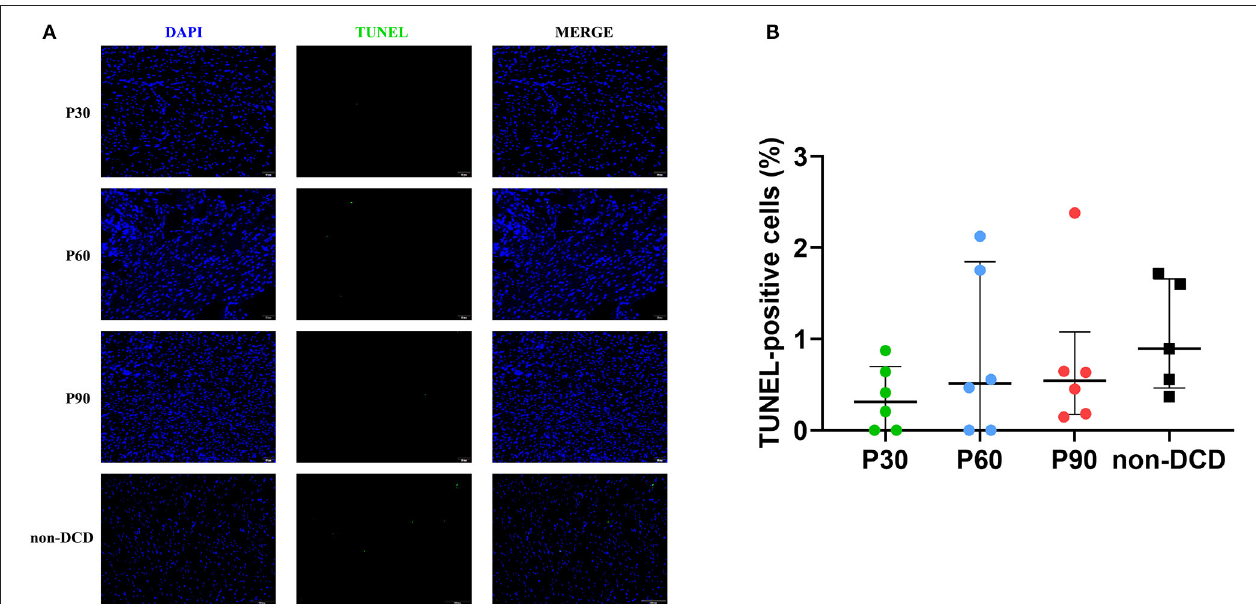
FIGURE 7 | Apoptosis evaluation of the donor heart during ESHP. (A) Representative photomicrographs of myocardial tissue stained with DAPI (blue), nuclei with fragmented DNA shown by TUNEL staining, and merged image (magnification of 20; scale length: 50 µ m); (B) Quantification of TUNEL-positive cells (as a percentage). n = 6 for P30, P60, and P90 groups, n = 5 for non-DCD group. Data represented as median and interquartile range. DAPI: 4 ′ ,6-diamino-2-phenylindole (DAPI, blue); DCD, Donation after circulatory death; ESHP, Ex situ heart perfusion; TUNEL, terminal deoxynucleotidyl transferase-mediated dUTP nick end-labeling.